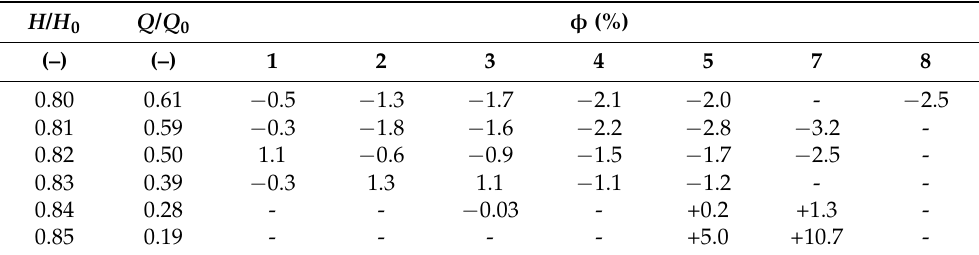
Figure 8. Variation of the turbine relative efficiency for the investigated operation regimes, with and without air injection. Table 2. Variation of turbine efficiency ( ∆ η (%)) for the tested void fractions.